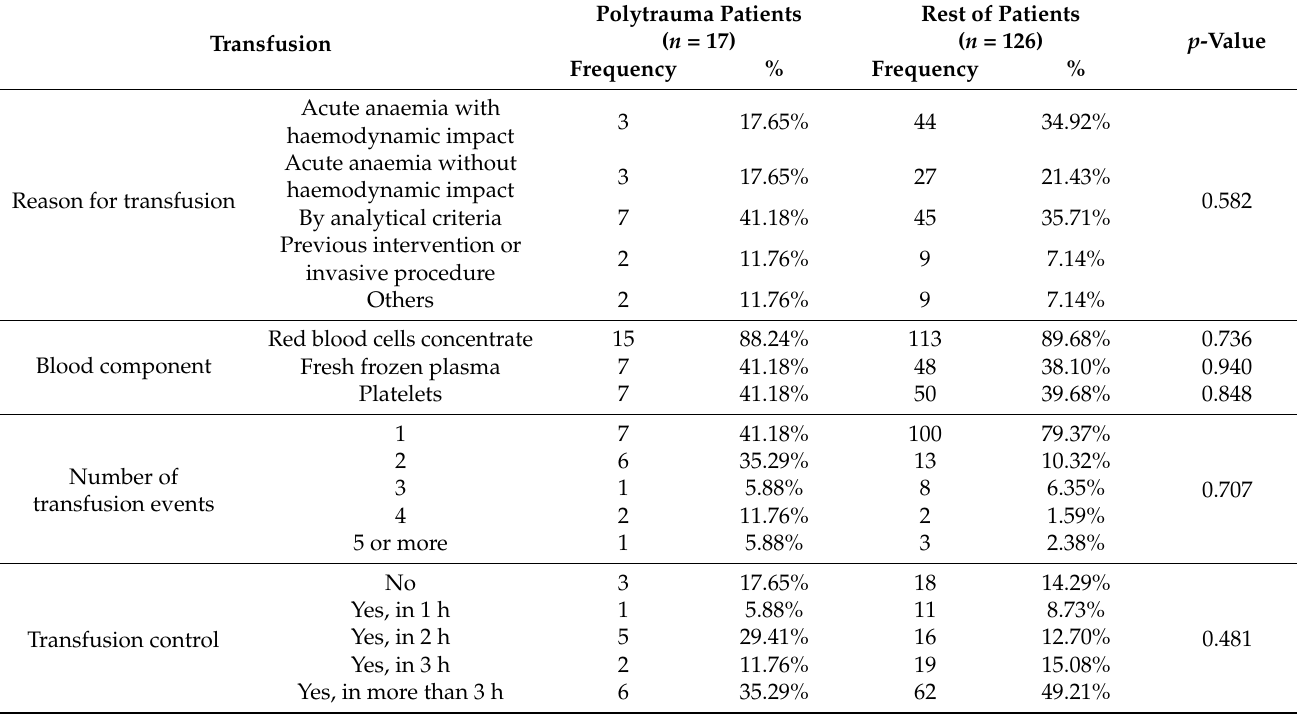
Table 4. Transfusion practice description.